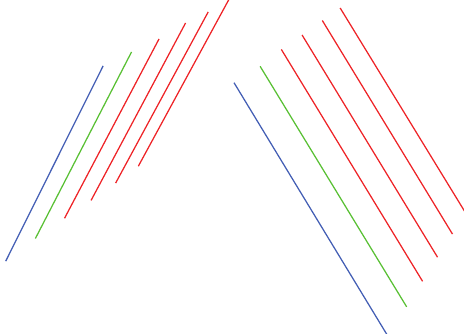
Figure 4: Space layout of the pile in the corner of roadway.